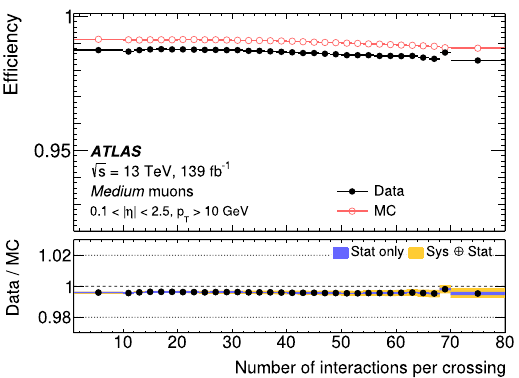
Fig. 22 Muon reconstruction and identification efficiency for the Medium identification criteria measured in Z → μμ events as a func- tion of the integrated luminosity interval (left) and the actual number of interactions per bunch crossing (right) for muons with p T > 10 GeV and 0 . 1 < | η | < 2 . 5. The statistical uncertainty in the efficiency mea-